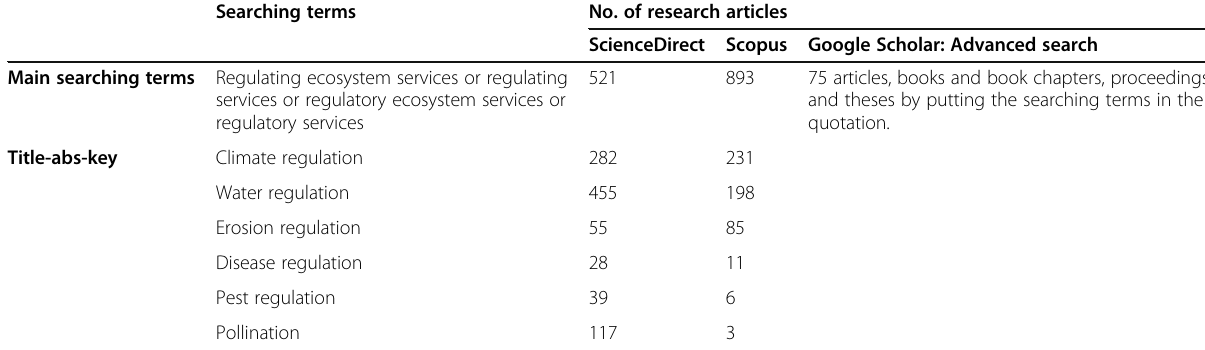
Table 1 Searching outputs from ScienceDirect, Scopus, and Google Scholar database of time span 2005 to April of 2019 Searching terms